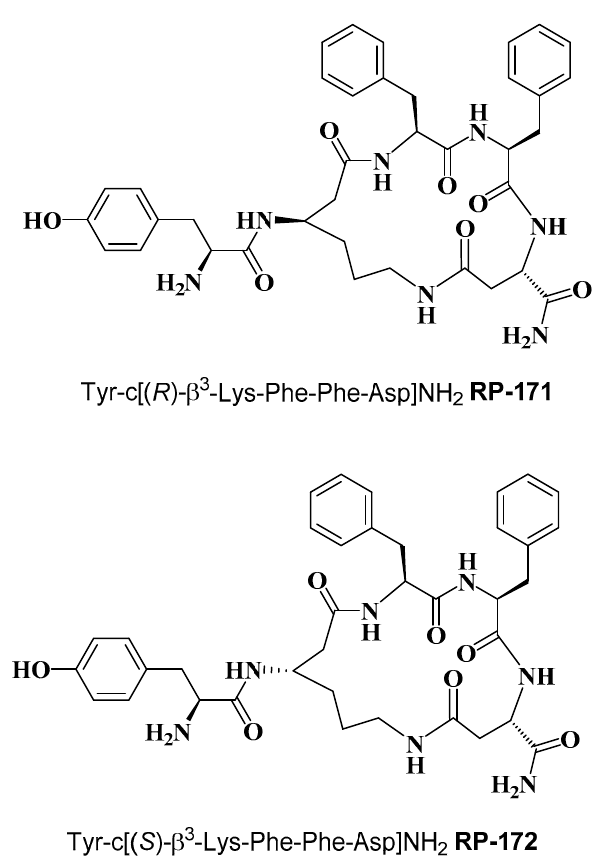
Figure 1 . Chemical structure of RP-171 and RP-172 . Figure 1. Chemical structure of RP-171 and RP-172